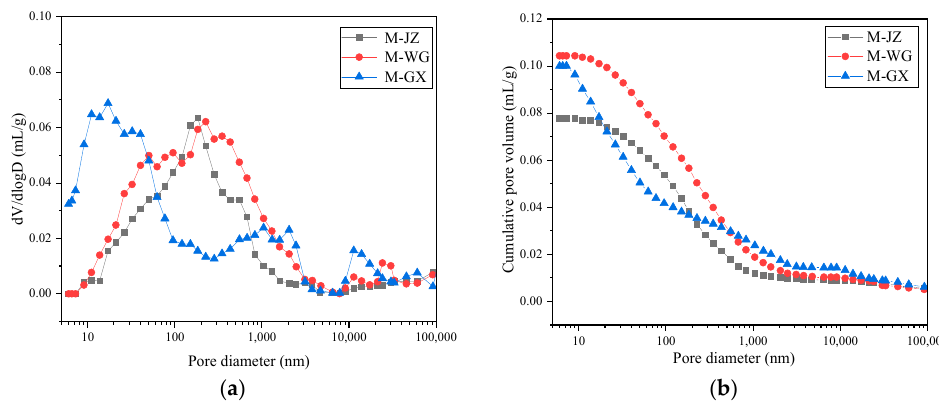
Figure 9. Pore size distribution and cumulative pore volume of ordinary mortar (M-JZ), recycled mortar (M-WG) and modified recycled mortar (M-GX): ( a ) pore size distribution; ( b ) cumulative pore volume.